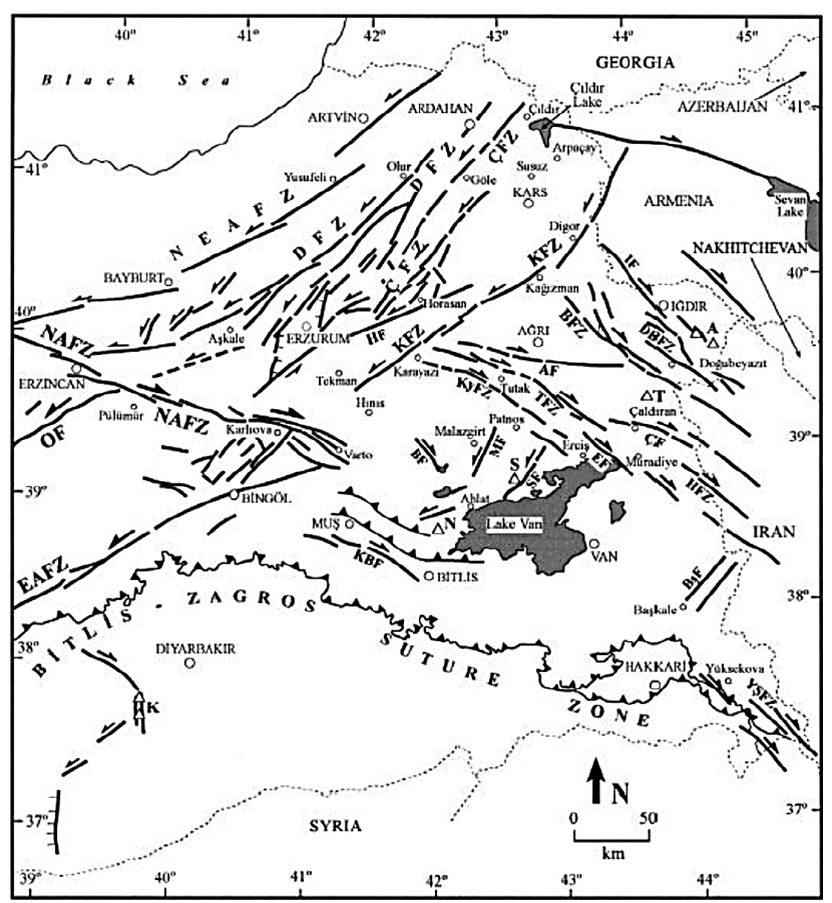
Fig. 3. Map of active faults in the Van region (Bozkurt, 2001).